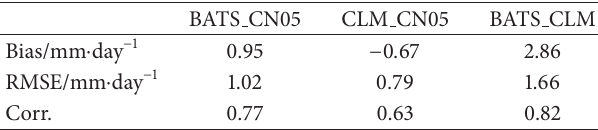
Table 4: Statistical values between the simulated and observed summer mean daily precipitation during